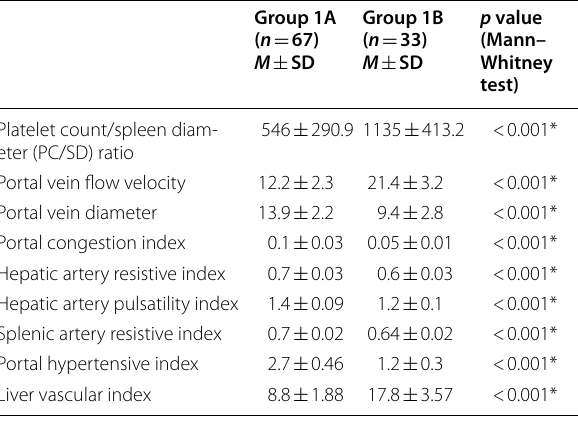
*High significant difference, P <